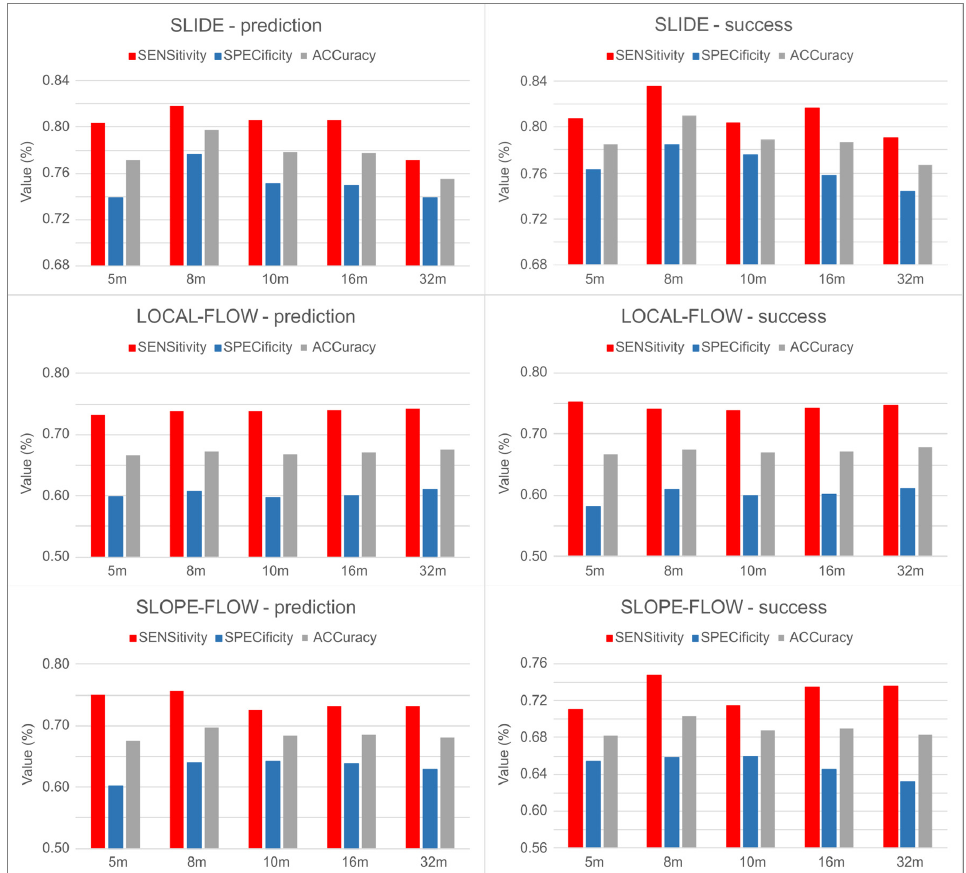
Figure 4. Barplots of the main validation indices of the confusion matrix (sensitivity, specificity and accuracy) of each modelling procedure with respect to the three different landslide typologies, both in prediction and in success validation.